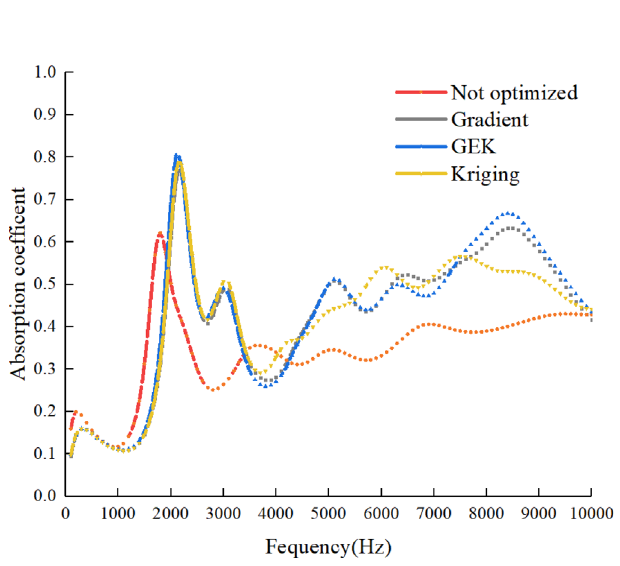
Figure 7. Sound absorption coef fi cient curves of different optimization models at full